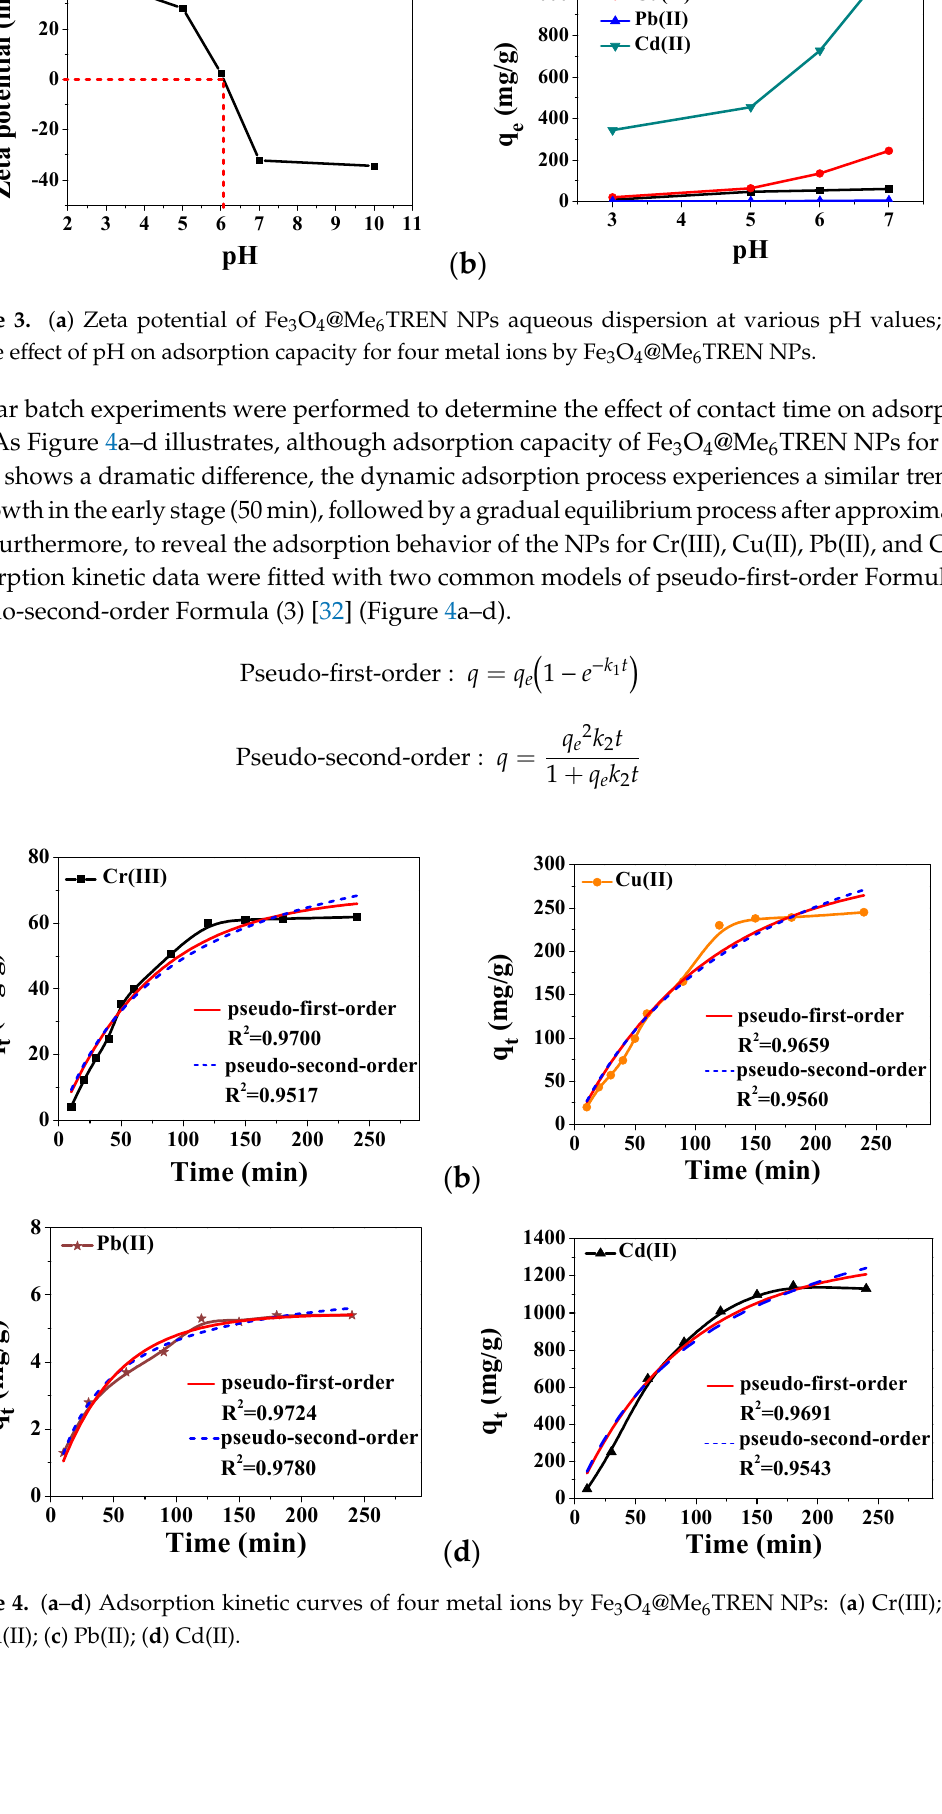
Figure 3. ( a ) Zeta potential of Fe 3 O 4 @Me 6 TREN NPs aqueous dispersion at various pH values; ( b ) the effect of pH on adsorption capacity for four metal ions by Fe 3 O 4 @Me 6 TREN NPs.